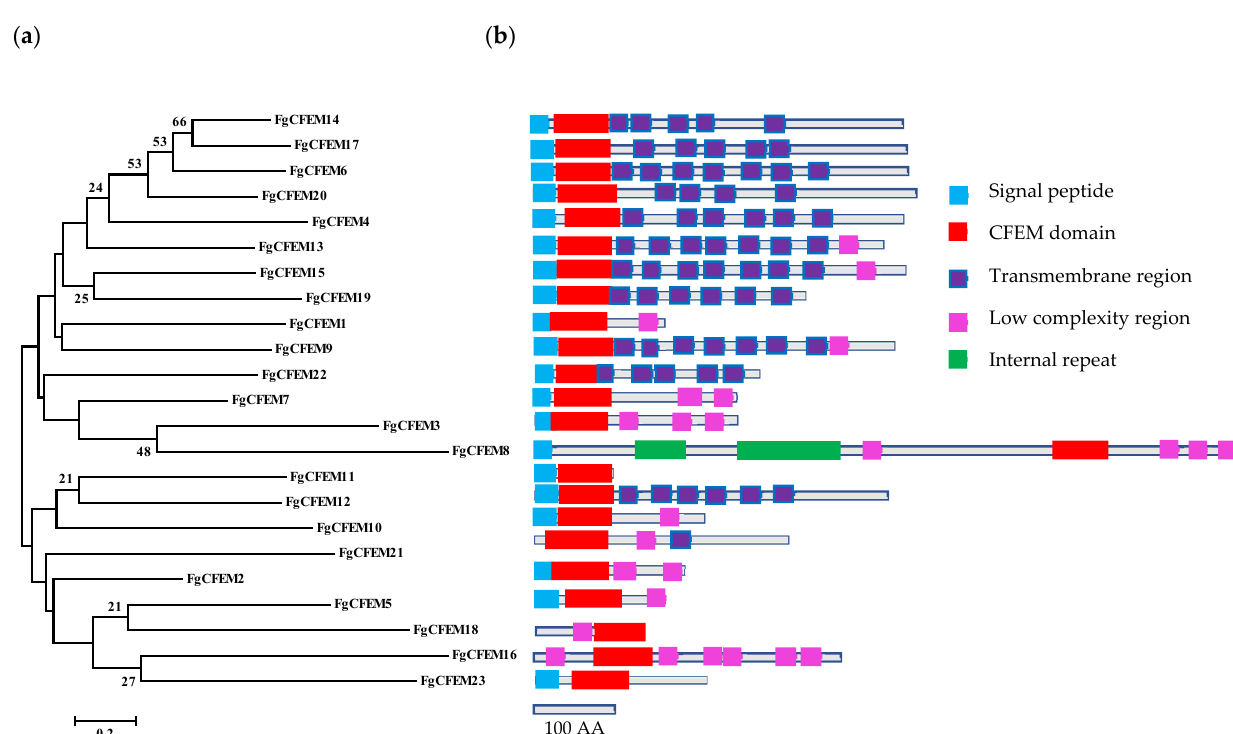
Figure 1. Phylogenetic analysis ( a ) and structure diagram ( b ) of the CFEM (Common in Fungal Extracellular Membrane) proteins in F. graminearum. A phylogenetic tree of adjacent connections was constructed based on amino acid sequences of FgCFEMs. The numbers on the nodes represent the percentage of their occurrences in the 1000 bootstrap replicates; the results show that more than 20% of the nodes are supported. The scale bar shows the number of amino acid differences at each site. The gray lines represent the length of each FgCFEM protein, the sky-blue box structure represents the signal peptide localization, red box represents CFEM structural domain, dark blue box represents transmembrane existence, purple represents low-degree complex regional protein, respectively. The scale represents the length of 100 AA in the